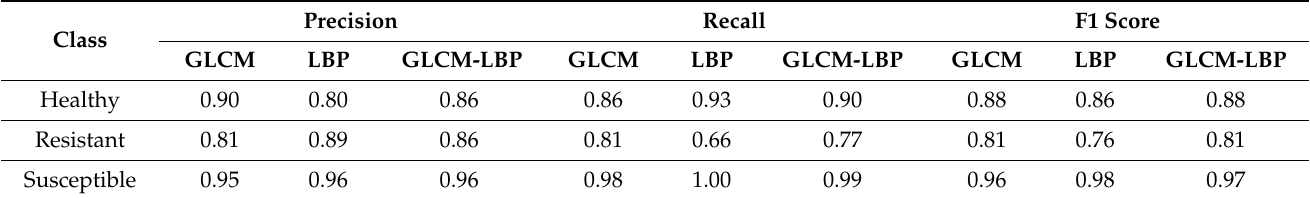
Table 5. Performance comparison for XGBoost classification on GLCM, LBP, and Combined texture GLCM-LBP images.